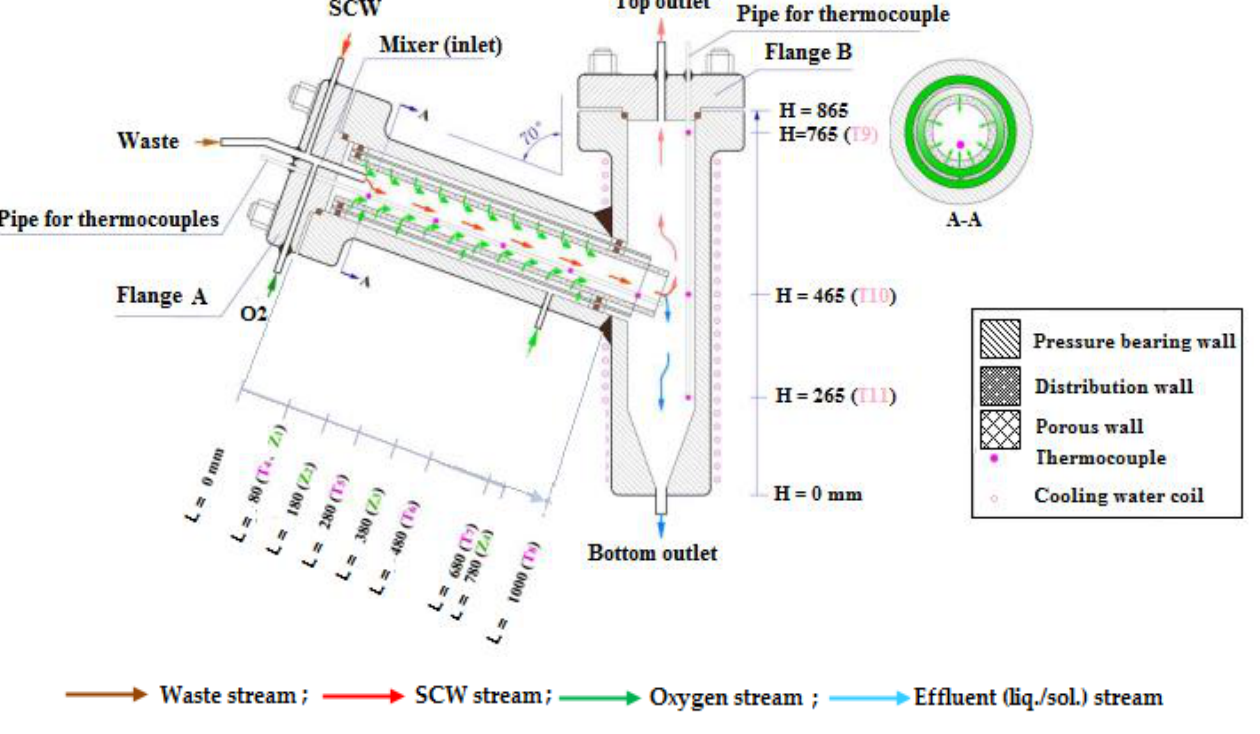
Figure 17. Scheme of the ‘Y’ shape reactor [91].